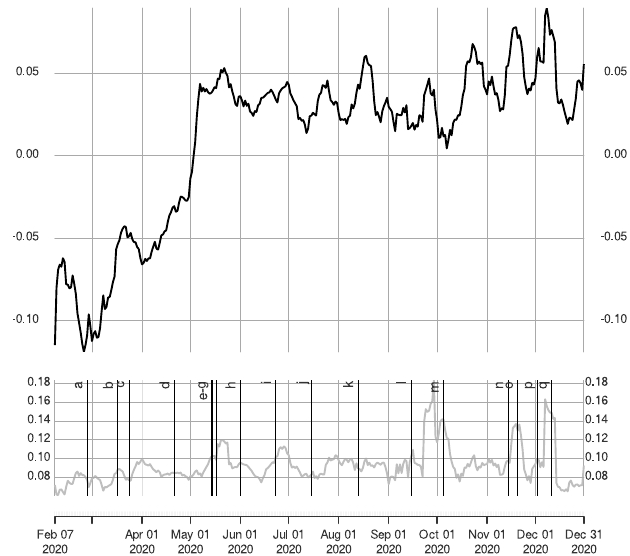
Figure 4. Year–Long time series of daily averaged of BERTweet’s compound sentiment polarity of COVID-19- related tweets, detrended, with its variance and significant events in Mexico . This time series is based on the same dataset collected [6] and restricted to Mexico from 2 February to 31 December 2020. Data were smoothed over via a 7-day rolling mean. Variance is also included for readability, as well as significant events found to cause an impact [2].